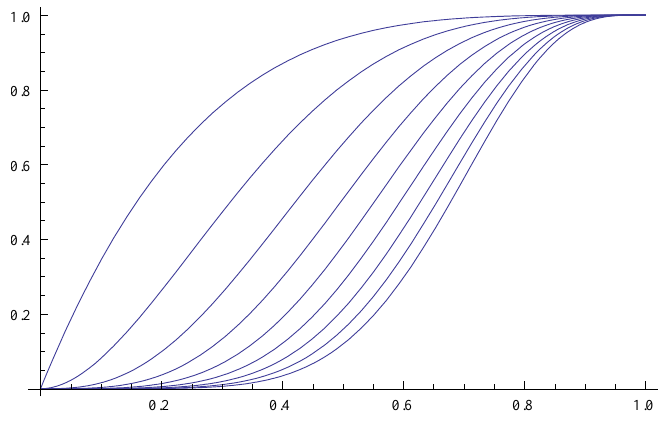
Figure 2. The reliability polynomial of the linear < n ,4,2> for n = 4,5,...,12.